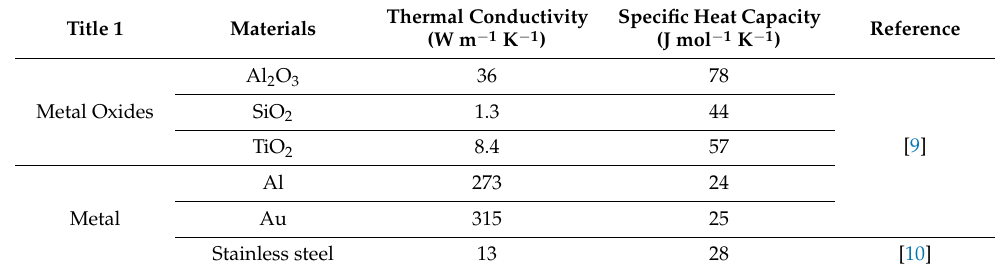
Table 1. Thermal conductivity and heat capacity of various metals and metal